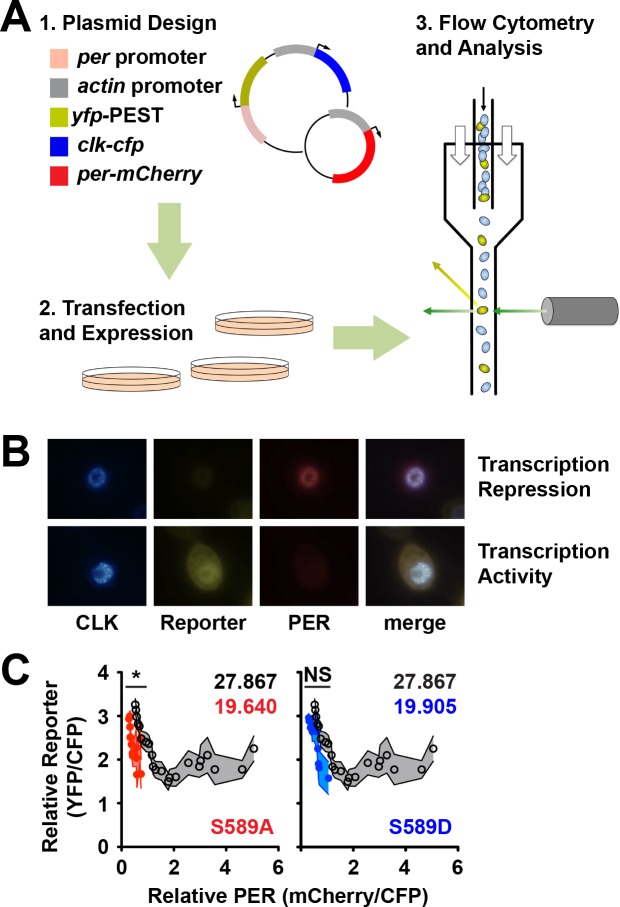
Fluorescence based transcription assay allows simultaneous measurement of transcription inhibition and protein stability.(A) Flow chart of the principles behind the fluorescence-based transcription assay. (1) Actin promoter (grey) driven clk-cfp (blue) and per promoter (light red) driven yfp (yellow) is cloned into the same expression plasmid and co-expressed in S2 cells with plasmid carrying actin promoter (grey) driven per-mCherry (red). (2) Cells are transfected and then (3) analyzed for fluorescence signal by flow cytometry. (B) Representative images of S2 cells expressing plasmids described in panel A that express high PER and low reporter (top row) and low PER and high reporter (bottom row). Expression of dCLK (blue), reporter (yellow), PER (red) is shown, with a merged image of all three signals. (C) CFP (dCLK)-positive cells were quantified for YFP (reporter) and mCherry (PER) expression using flow cytometry. mCherry signal was binned, and both mCherry and YFP signals were normalized to CFP signal and plotted as shown. S589A (red dots) and S589D (blue dots) were compared to wild-type PER (open black circles). Each data point represents the mean of the binned cells, ±SD. Thickness of the curve reflects SD. *p<0.05. NS, not statistically significant. Significance was measured by Mann-Whitney test. Colored inset numbers represent corresponding PER fluorescence signal per cell in arbitrary units as a measure of PER stability (Black numbers represent wild type PER stability).